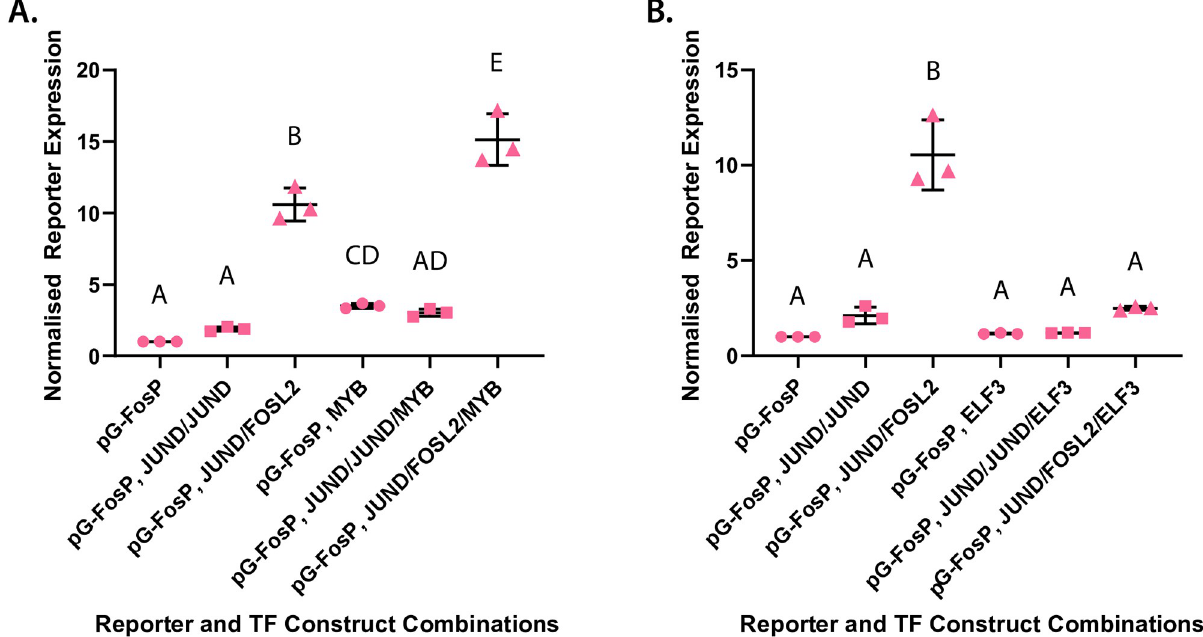
Fig 4. MYB up-regulates while ELF3 down-regulates basal and AP-1 dimer-induced Fos promoter activity. Reporter expression levels from construct with luciferase reporter gene under control of murine Fos promoter (FosP) relative to expression output of Renilla reporter plasmid. Cell treatment with (A) MYB alone, MYB and JUND:JUND homodimers, and MYB and JUND:FOSL2 heterodimers compared against control set in the absence of MYB; and (B) ELF3 alone, ELF3 and JUND:JUND homodimers, and ELF3 and JUND:FOSL2 heterodimers compared against control set in the absence of ELF3. Average expression level values ( ± S.D.) for each construct normalized to expression output of promoter construct subject to no transcription factor treatment. Groups determined by one-way ANOVA to be significantly different (p < 0.05) from one another are labeled with different letters; to indicate p > 0.05, groups are labeled with the same